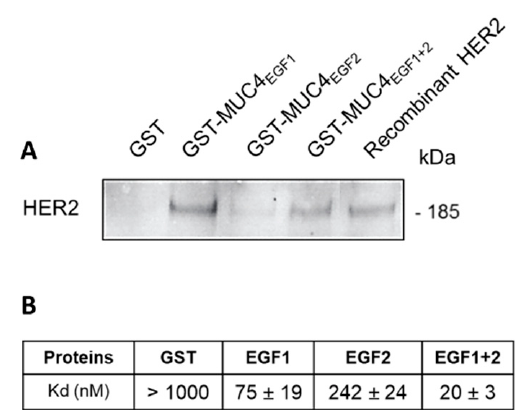
Figure 2. MUC4 EGFs domains physically interact with HER2 in vitro. ( A ) Immunoblot with anti-HER2 antibody of GST pull-down assays of recombinant HER2 with GST alone, GST-MUC4 EGF1 , GST-MUC4 EGF2 , and GST-MUC4 EGF1+2 . Recombinant HER2 alone was used as control. ( B ) Measurement of binding affinities between fluorescent tagged HER2 and GST-MUC4 EGF1 (EGF1), GST-MUC4 EGF2 (EGF2), GST-MUC4 EGF1+2 (EGF1+2), or GST alone (negative control), using MST.